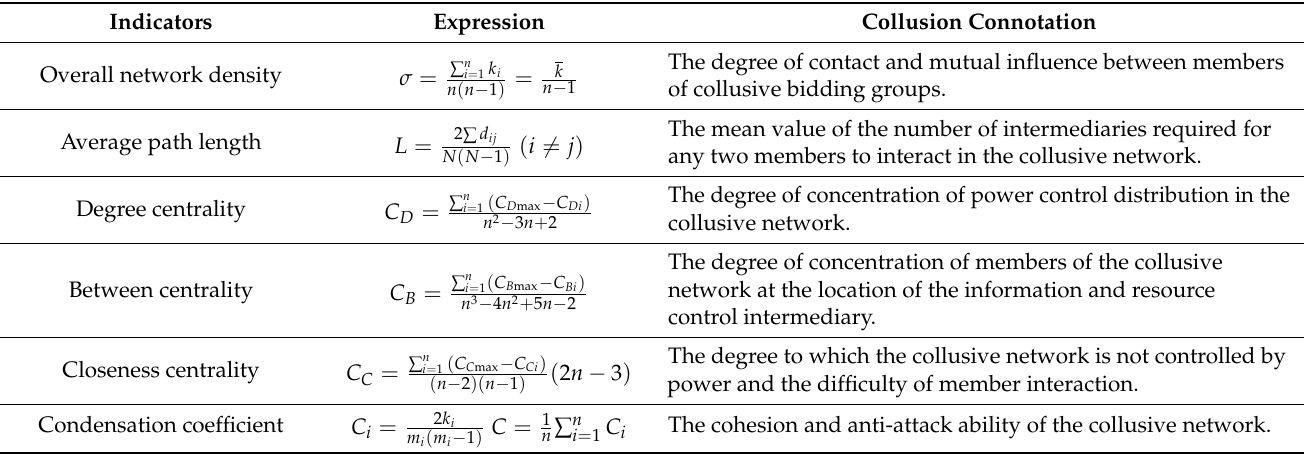
Table 2. Collusive network